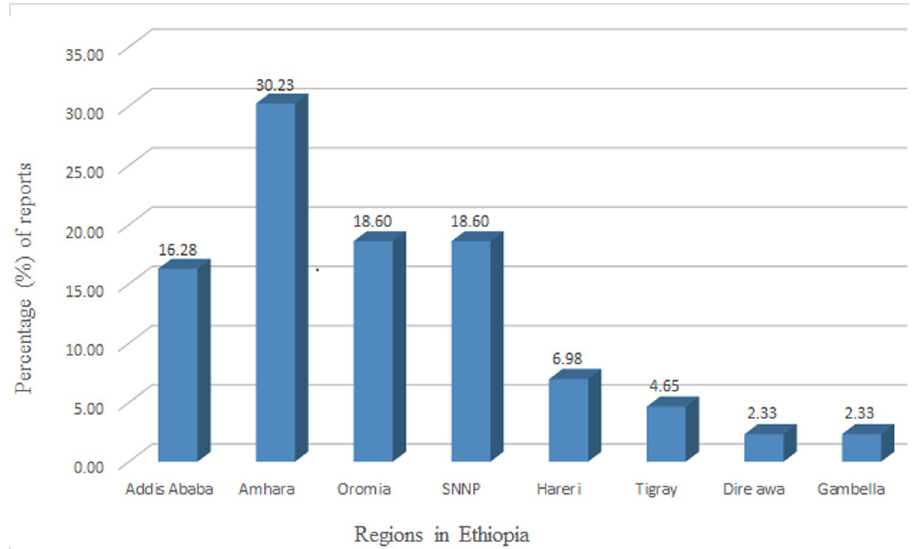
Fig 2. Percent of published articles in different regions of Ethiopia. The country has 9 regions and two city administrations. Reports were from 8 of them which are indicated in the figure. Reports were not found from Afar, Somali, and Benishangul Gumuz regions during the period of data collection (SNNP = South Nation and Nationalities Region).